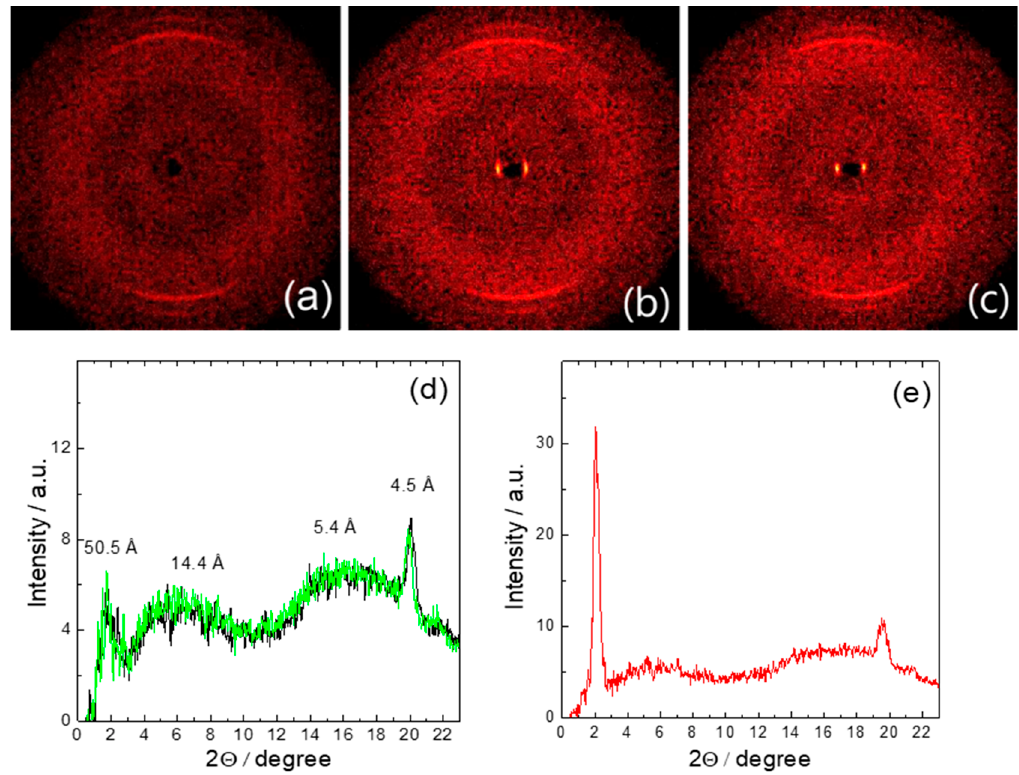
Figure 5. Two-dimensional-X-ray patterns for: ( a ) pure stretched PE film (30 ◦ C); ( b ) stretched PE-FLC nanocomposite in the SmC* phase (~70 ◦ C); ( c ) stretched PE-FLC nanocomposite in the SmA* phase (~106 ◦ C). For ( a – c ), stretching direction is horizontal. The wide-angle X-ray scattering (WAXS) intensity profile measured for ( d ) the pure stretched PE film (at 30 ◦ C and 90 ◦ C, black and green curves, respectively) and ( e ) for the PE-FLC nanocomposite (at 70 ◦